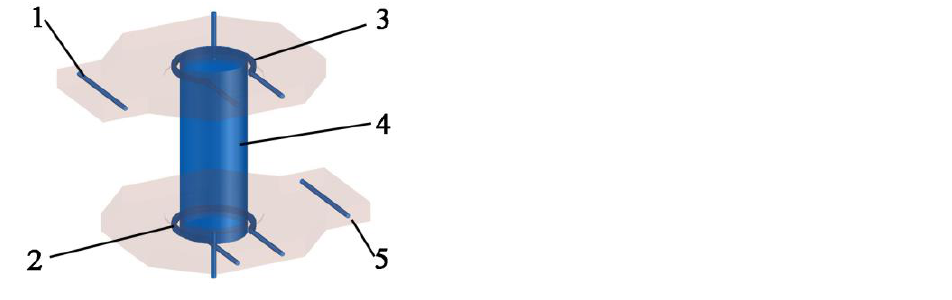
Figure 3. The cooling water system in the CS: ( 1 ) straight tubes; ( 2 ) combined tube; ( 3 ) combined tube; ( 4 ) cavity; ( 5 ) straight tube.